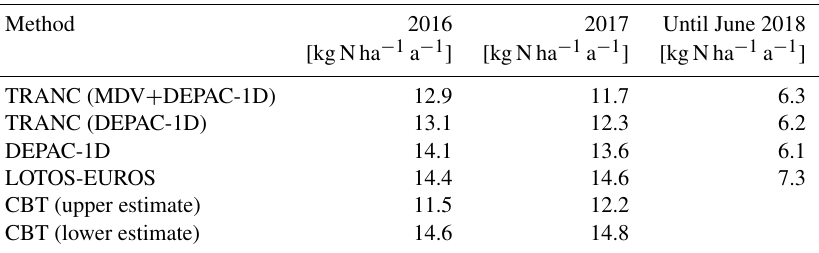
Table 3. Annual (cid:54) N r deposition of TRANC, DEPAC-1D, LOTOS-EUROS, and CBT for 2016, 2017, and from January to June